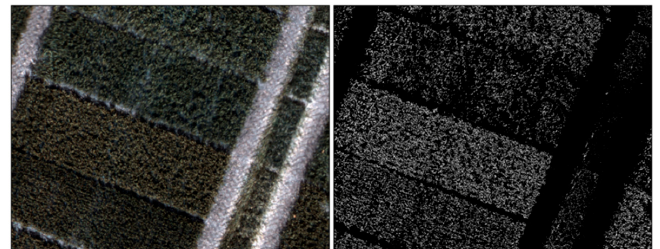
Figure 6. Example image of an RGB image of wheat trial plots and right the ExGR mask output. In the ExGR mask, white represents green classified pixels and black non-green pixels. Imagery is from the 21 June 2017 UAV data collection campaign.